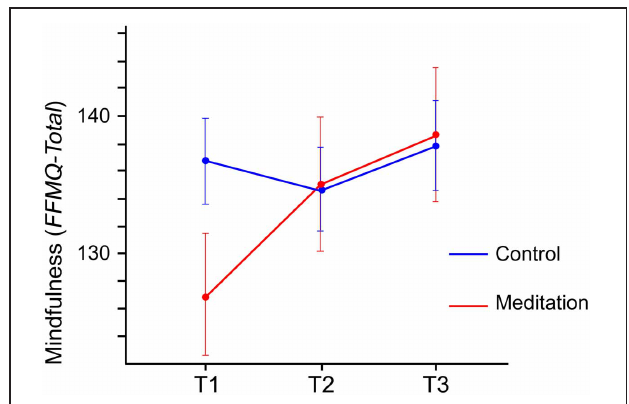
FIGURE 3 | Total mindfulness scores (FFMQ-total, possible range 39–195) for meditation group and control group from T1 to T3. The figure depicts the significant interaction between Group and Time. Error bars show the standard error of the mean.